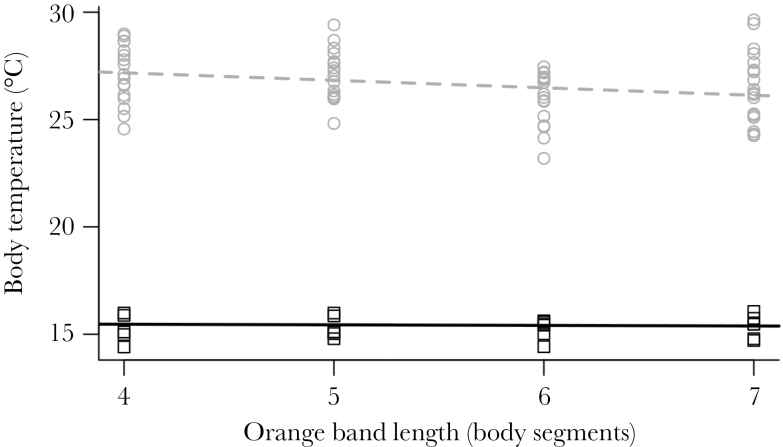
Body temperature of caterpillars with varying orange band lengths when placed outdoors either in full sun or shade. Gray circles and dashed line represent caterpillars in full sun; black squares and solid line represent caterpillars in shade. Lines show interacting fixed effects from a mixed model (P = 0.0365). n = 90 observations of 45 caterpillars.